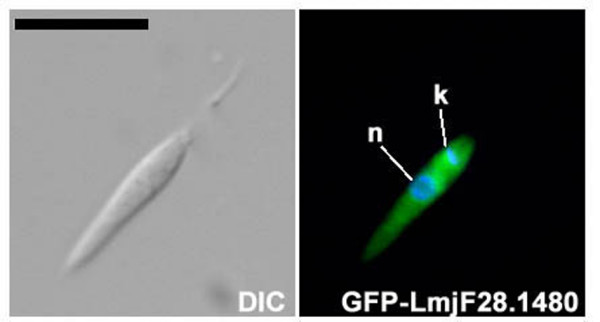
GFP-LmjF28.1480 localises to the cytosol. Localisation of GFP-fused LmjF28.1480 in live L. major promastigotes (DIC image shown on the left). The GFP fluorescence signal is shown in green merged together with the DAPI staining of DNA in blue (n: nucleus; k: kinetoplast). Scale bar = 10 μm.